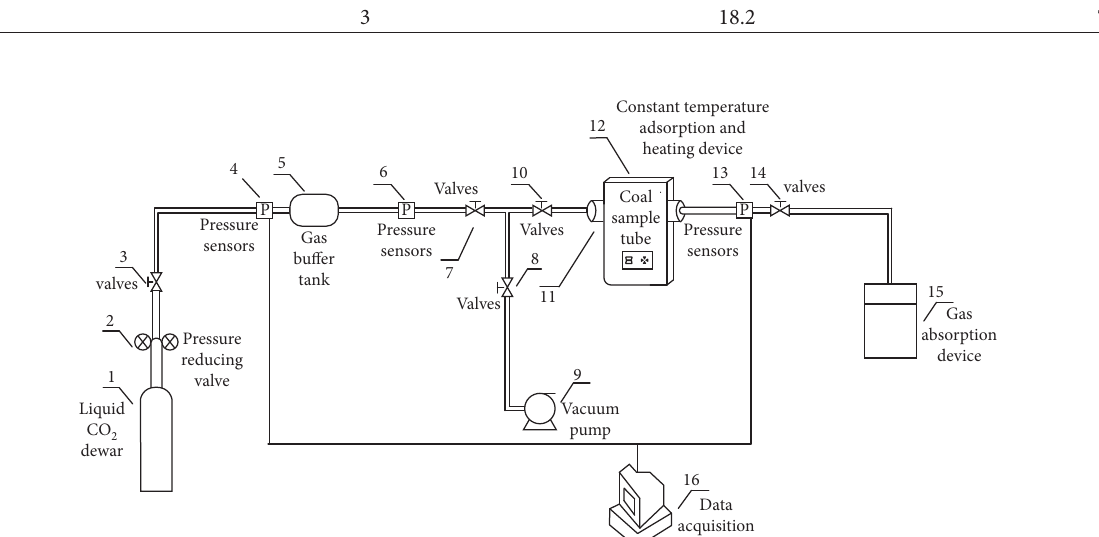
Figure 6: Scheme of the CO 2 adsorption experimental